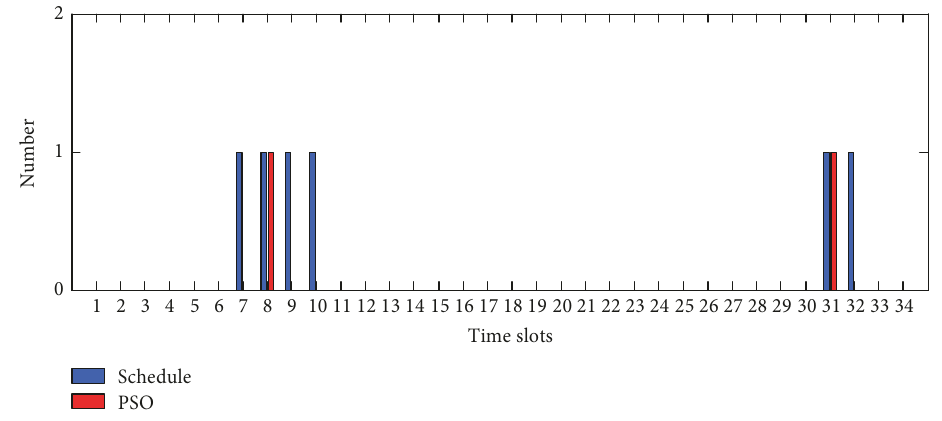
Figure 8: The number of EVs waiting using the schedule and PSO strategies.